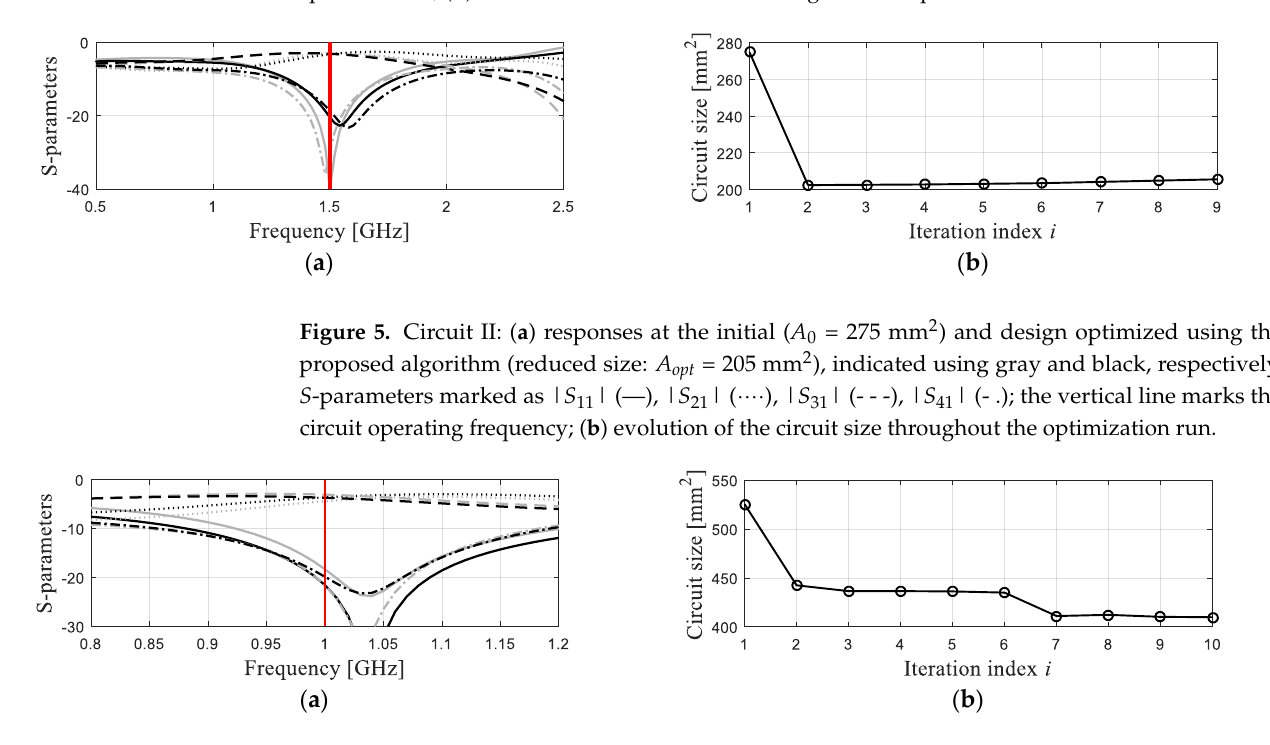
Figure 4. Circuit I: ( a ) responses at the initial ( A 0 = 52 mm 2 ) (gray) and design optimized using the proposed algorithm (reduced size: A opt = 31 mm 2 ) (black); the red horizontal line marks the design specifications; ( b ) evolution of the circuit size throughout the optimization run.